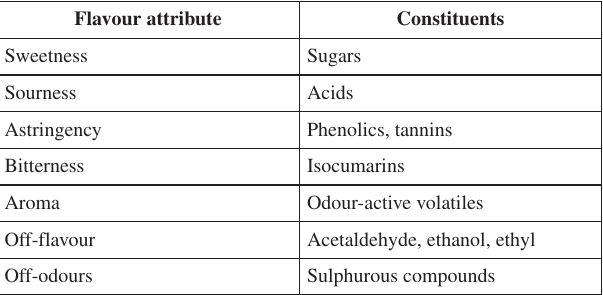
Table 1 The relationship of components on